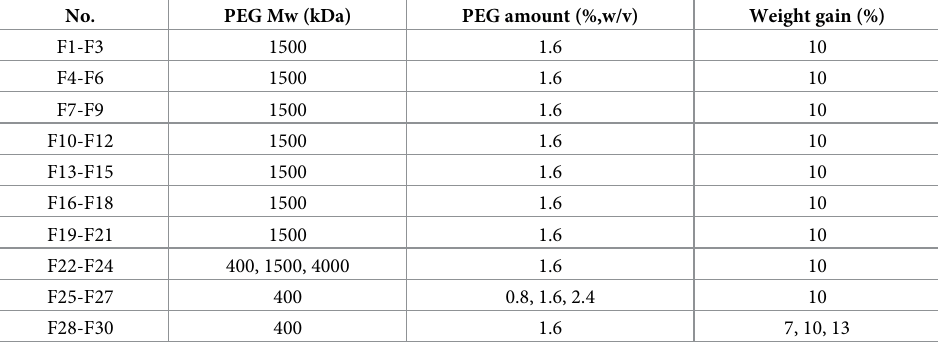
Table 2. Coating membrane formulations and levels used in the single-factor experiments.